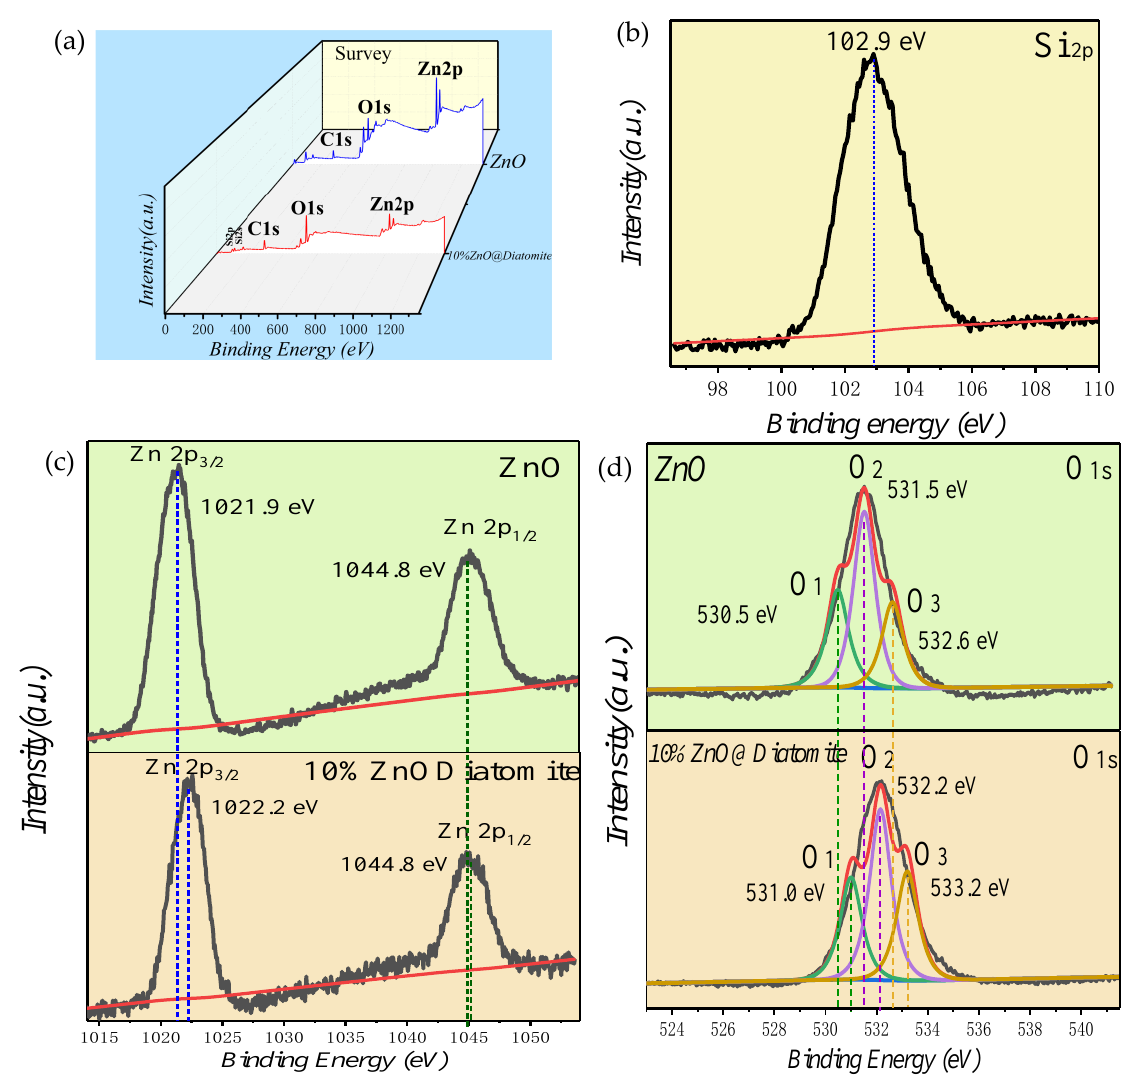
Figure 5. XPS survey spectra ( a ) and Si 2p ( b ), Zn 2p ( c ), and O 1s ( d ) spectra for ZnO and 10% ZnO@diatomite. Table 1. Ratio of three binding energy levels of ZnO and 10% ZnO@diatomite. Table 1. Ratio of three kinds of surface oxygen species of ZnO and 10% ZnO@diatomite.